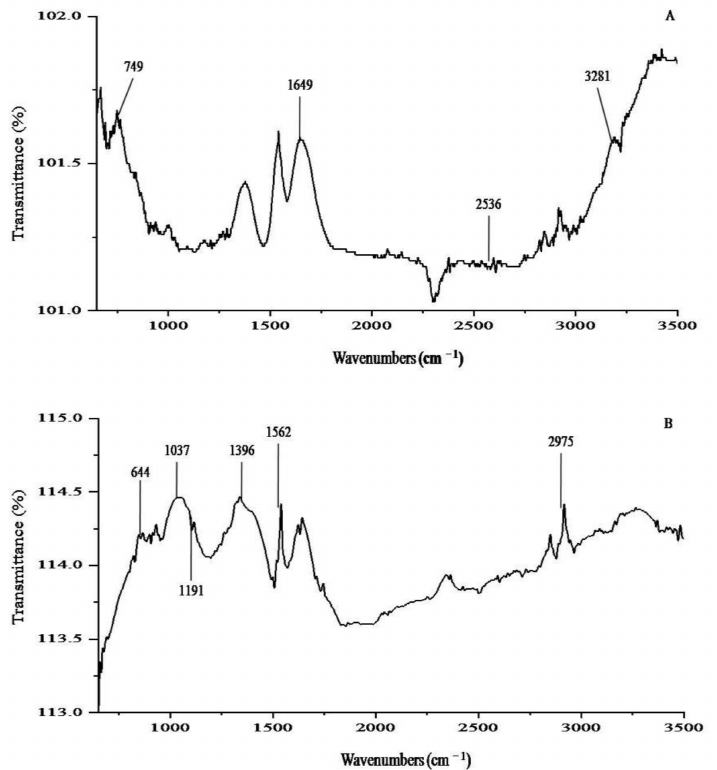
Figure 1. Characterization of the DNA sensor fabrication steps using a Fourier-transform infrared spectroscopy (FTIR) analysis of ( A ) the AuN/CNF bare electrode and ( B ) after modifications of the AuN/CNF electrode surface with a single stranded DNA (ssDNA) probe (AuN/CNF/ssDNA probe ) at a frequency scan of 500–3500 cm − 1 .